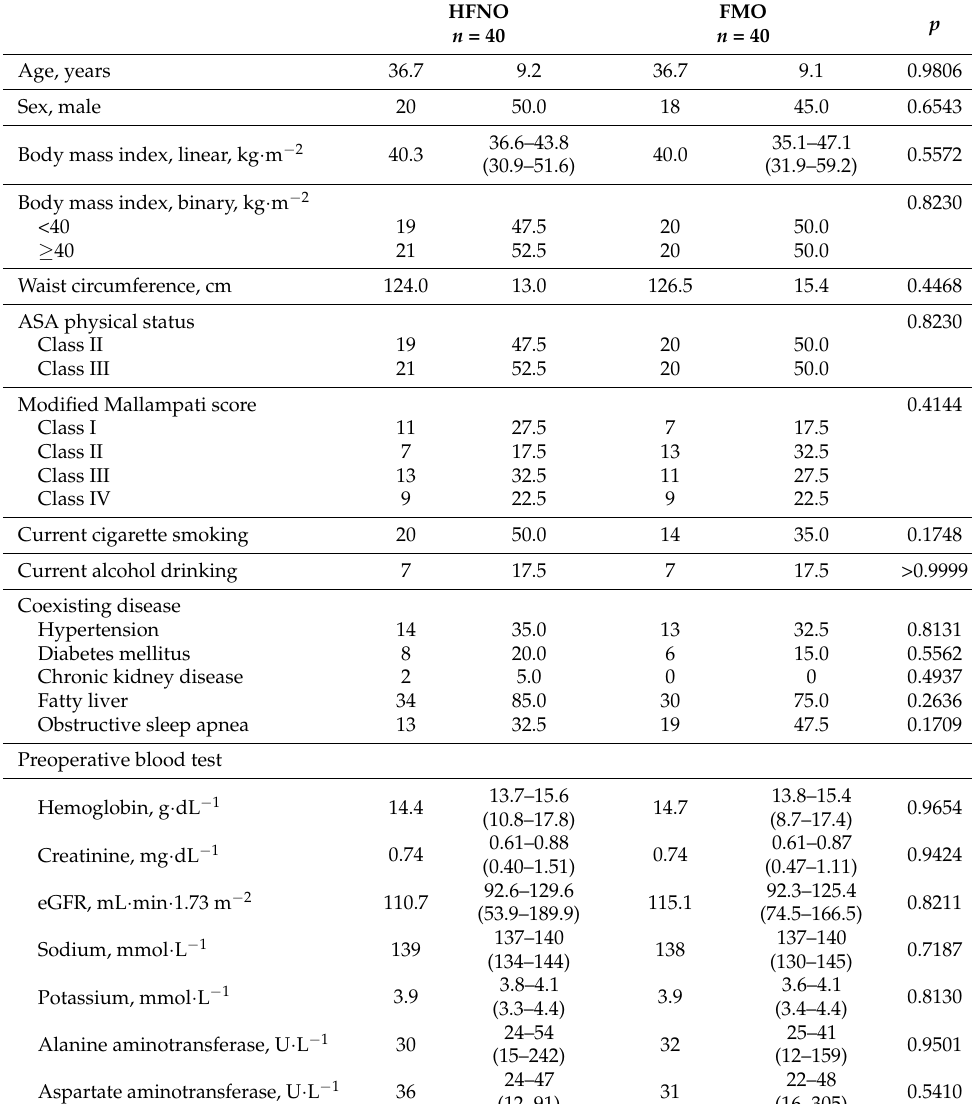
Table 1. Baseline patient characteristics.